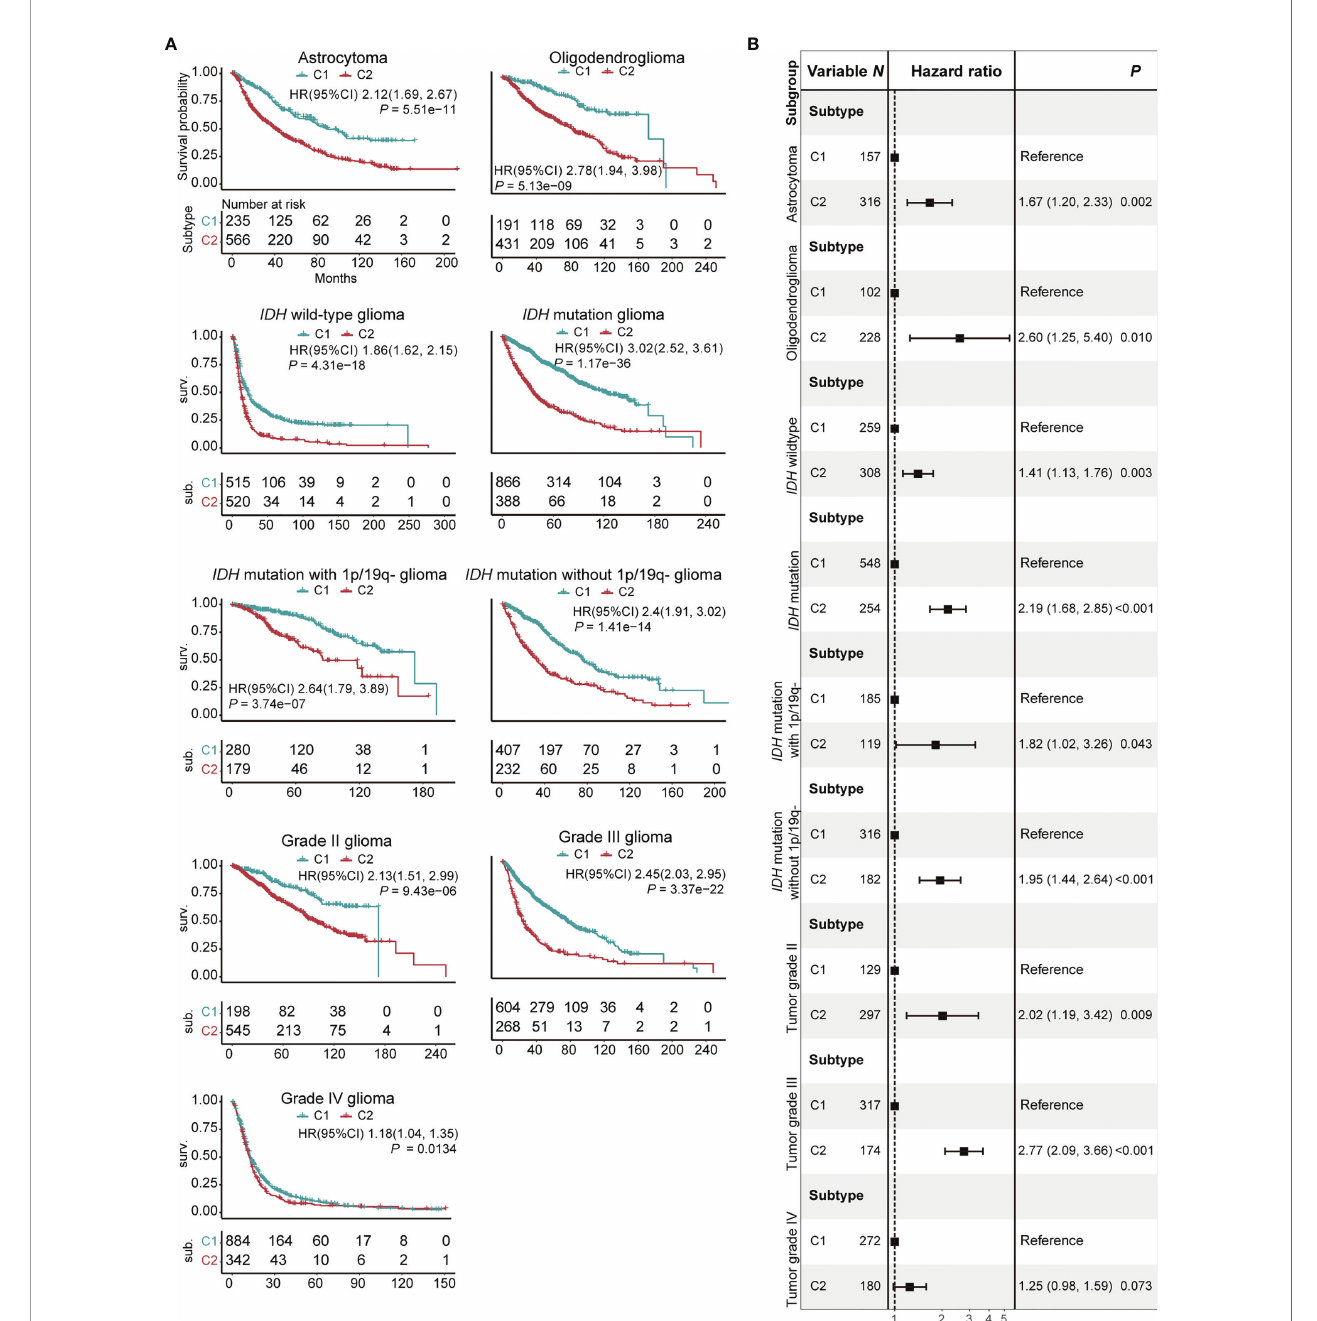
FIGURE 3 | Prognostic signi fi cance of C1/2 subtypes strati fi ed by different clinical variables. (A) Kaplan-Meier survival analysis of C1 versus C2 subtype. (B) Combined forest plot portraying multivariate Cox regression analysis of C1/2 subtypes after controlling age, gender, histology, IDH mutation, MGMT methylation, and co-deletion of 1p and 19q. 1p/19q-, co-deletion of 1p and 19q; HR, hazard ratio; CI, con fi dence